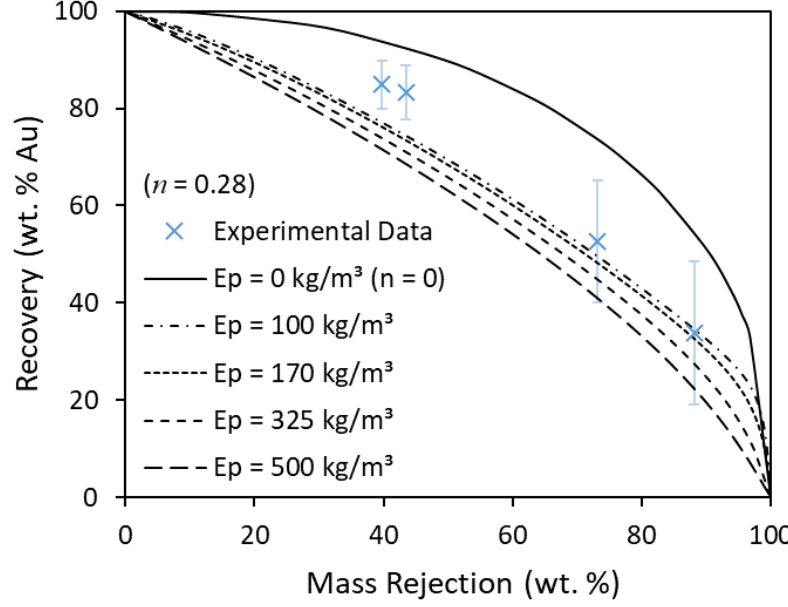
Figure 10. Recovery as a function of mass rejection comparing a set of model predictions with the experimental data [22]. The model results are based on a perfect separation with Ep = 0 kg/m 3 and n = 0, as well as Ep values of 100, 170, 325 and 500 kg/m 3 , where the ( D 50 – 1000) varied with particle size to the power –0.28.